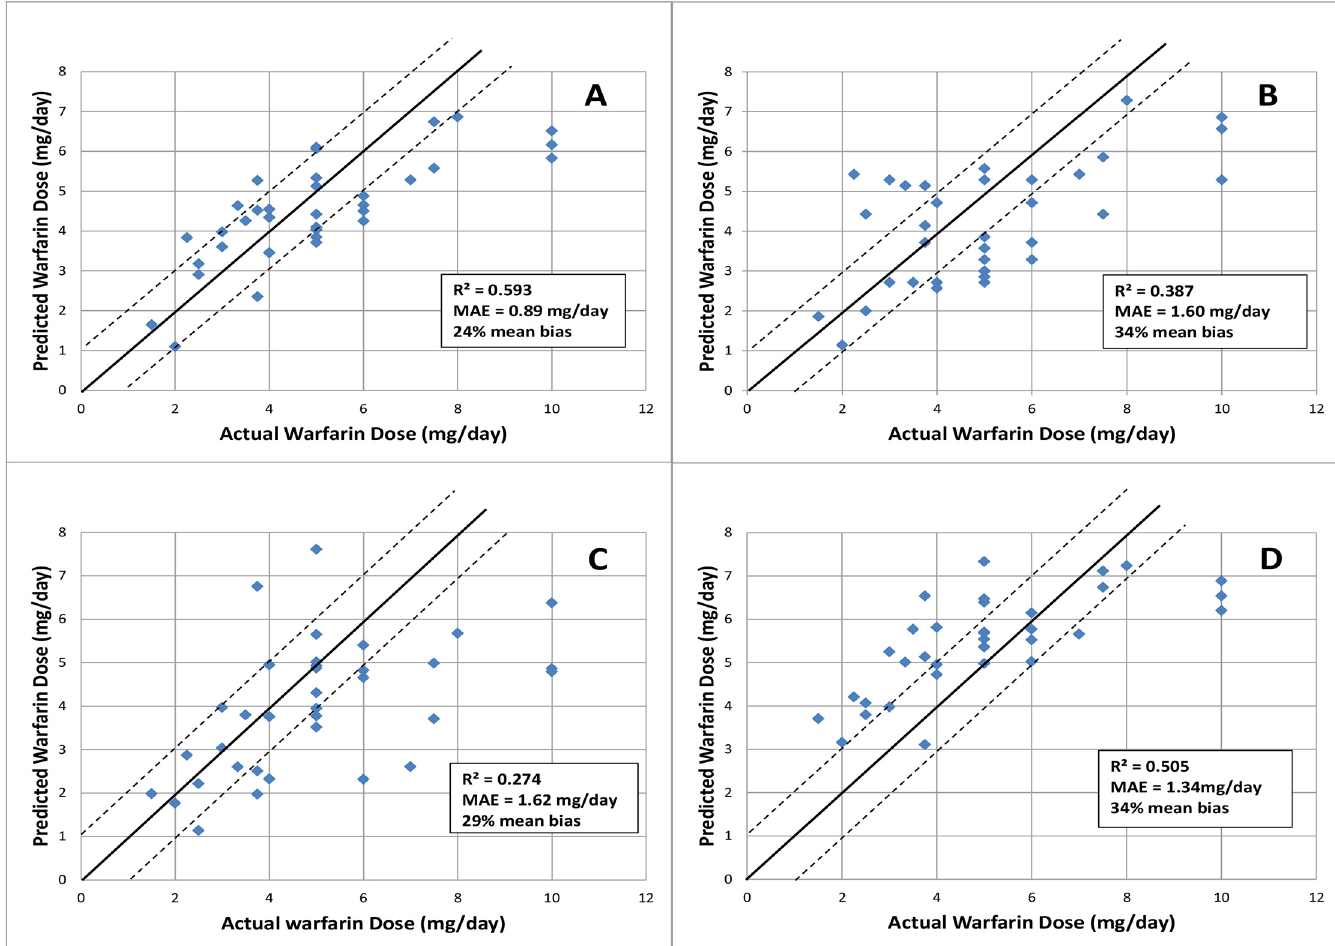
Fig 3. Validation of the admixture-adjusted pharmacogenetic algorithm for dose refinement in Caribbean Hispanics (upper plot A) as compared to two publicly available algorithms (i.e., IWPC-derived [37] and Lenzini et al [36] models, plots B and C, respectively) as well as a clinical non- genetic algorithm (plot D) in an independent sample of 55 Puerto Ricans from the Brownstone Clinic in Hartford, CT. Each filled diamond represents the observed versus predicted dose of each patient. The upper solid line is (predicted + 1 mg/day) of the actual dose, the middle solid line (i.e. 45% degree line) illustrates perfect prediction in this validation cohort, and the lower solid line is (predicted − 1 mg/day) of the actual dose. 1 mg/day change in warfarin dose is sufficient to change the INR by 0.5, a clinically meaningful